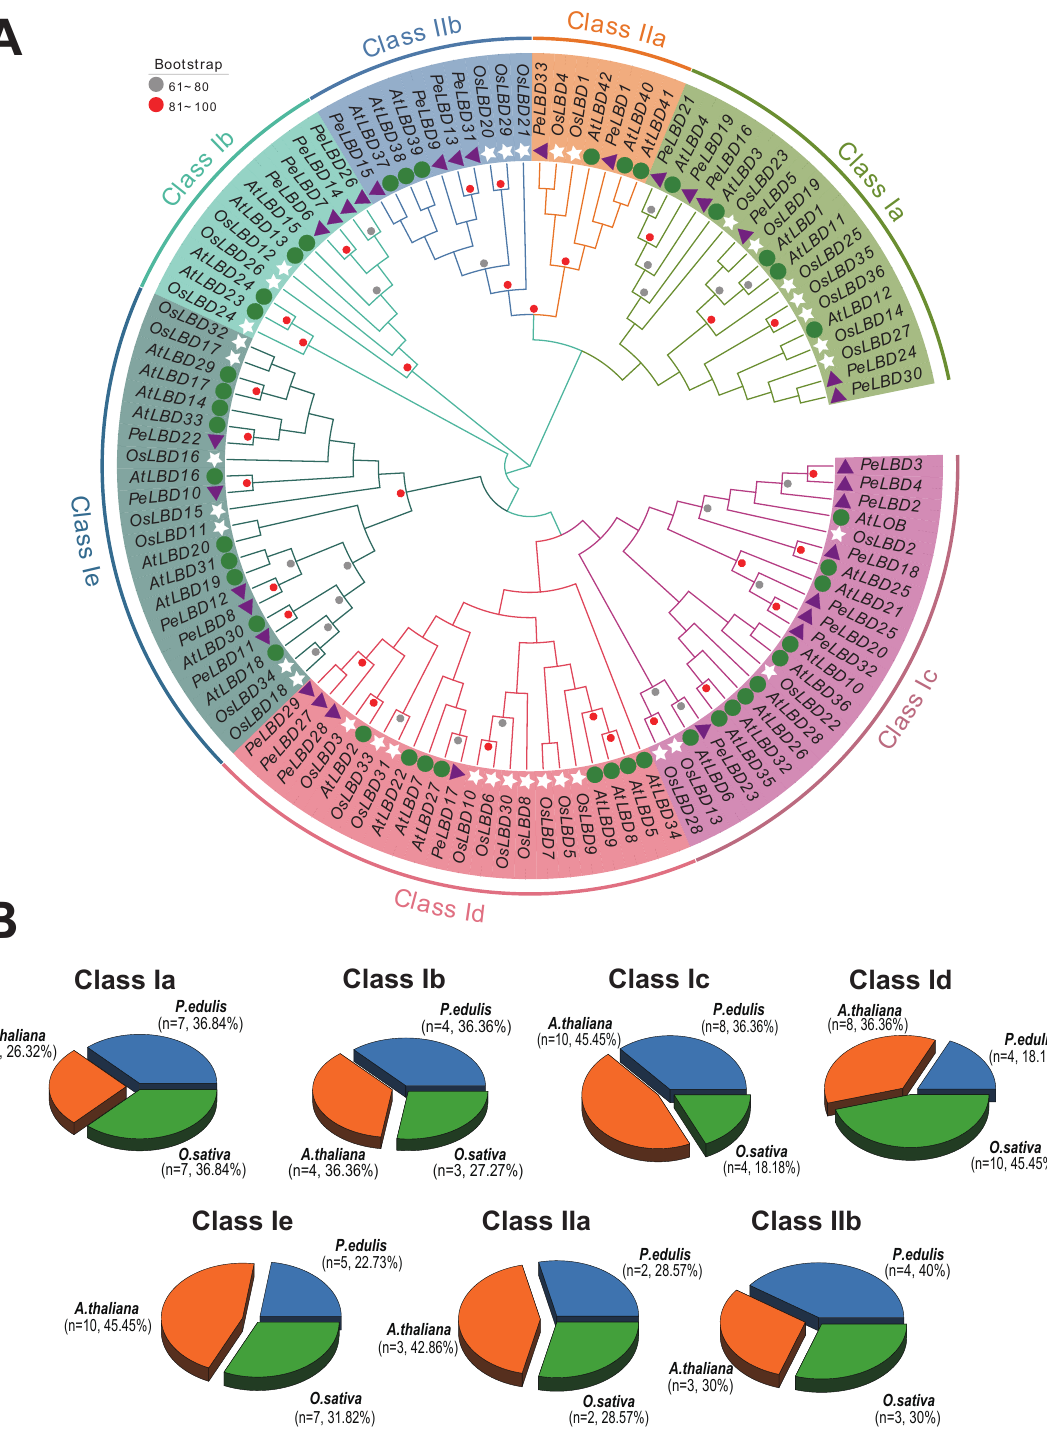
Figure 2. Phylogenetic tree of LBD proteins from passion fruit (Pe, Passiflora edulis ), Arabidopsis (At, Arabidopsis thaliana ) and rice (Os, Oryza sativa ). ( A ) A phylogenetic tree of the LBD protein family was constructed by MEGA 11 software using the maximum likelihood (ML) option with 1000 bootstrap replicates. Purple triangles, green circles and white stars indicate passion fruit, Arabidopsis and rice sequences, respectively; ( B ) Percentage of LBD gene family members in three species in each subgroup. The blue part represents the proportion of LBD gene in passion fruit, the orange part represents the proportion of LBD gene number in Arabidopsis and the green part represents the proportion of LBD gene in